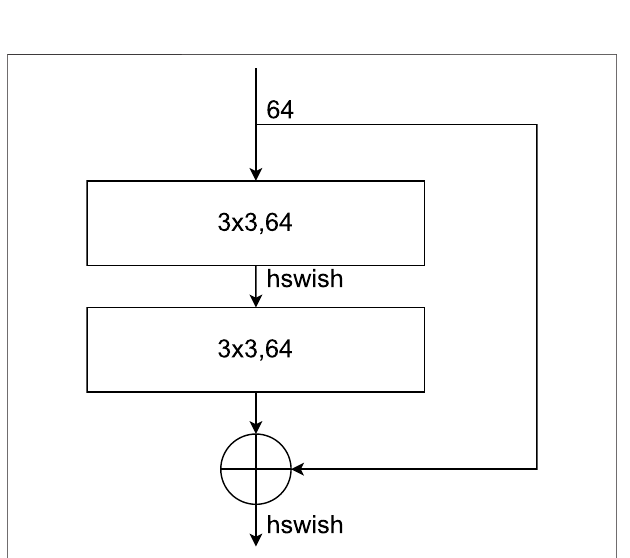
FIGURE 9 | Residual block with the H-swish function.